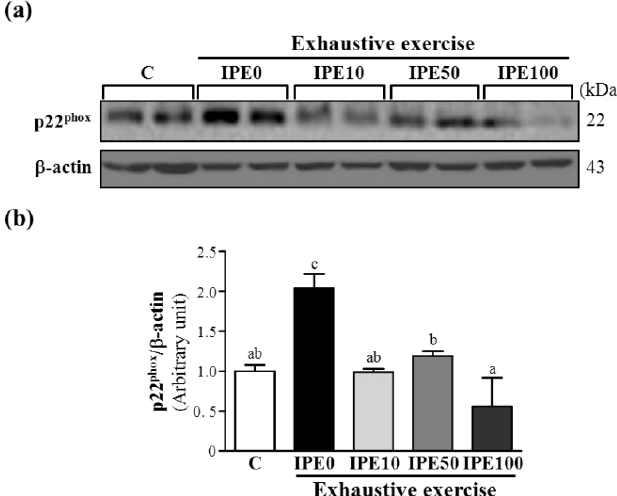
Figure 5. Effect of I. parviflora extract (IPE) supplementation on levels of the p47 phox subunit of NADPH oxidase in liver tissues after an exhaustive swimming exercise challenge. ( a ) Western blot of p47 phox and  -actin expression levels in the liver; ( b ) p47 phox protein expression was normalized to that of  -actin (internal control) by densitometry.